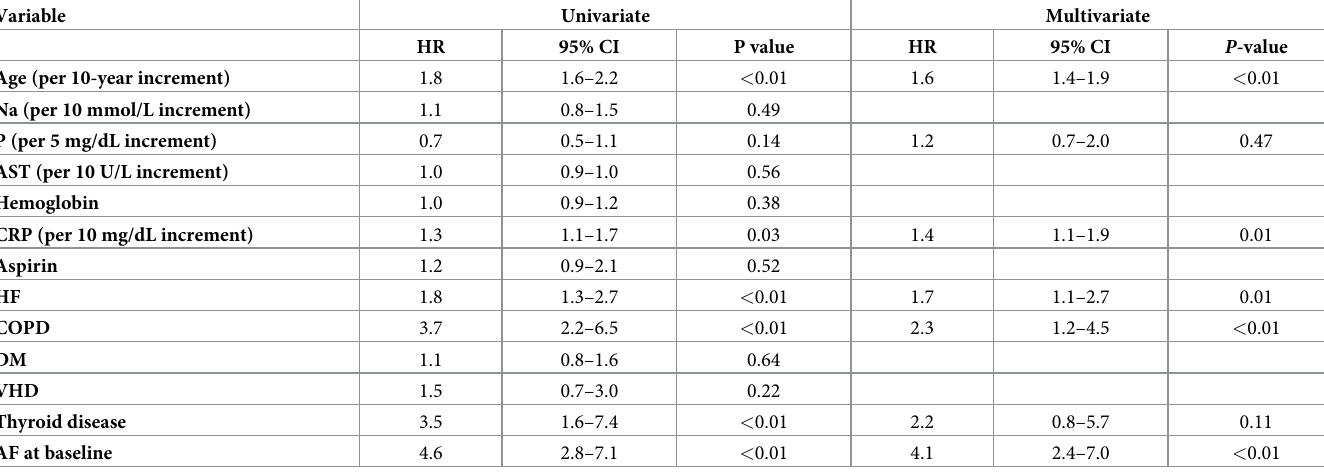
Table 2. Risk factors for mortality in incident hemodialysis patients a .